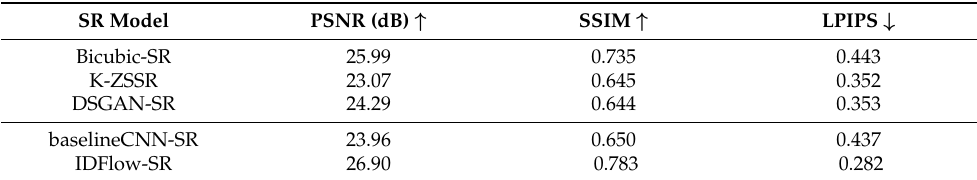
Table 3. SR performance of different SR models on RealSR-Test with a scale factor of 4 × .